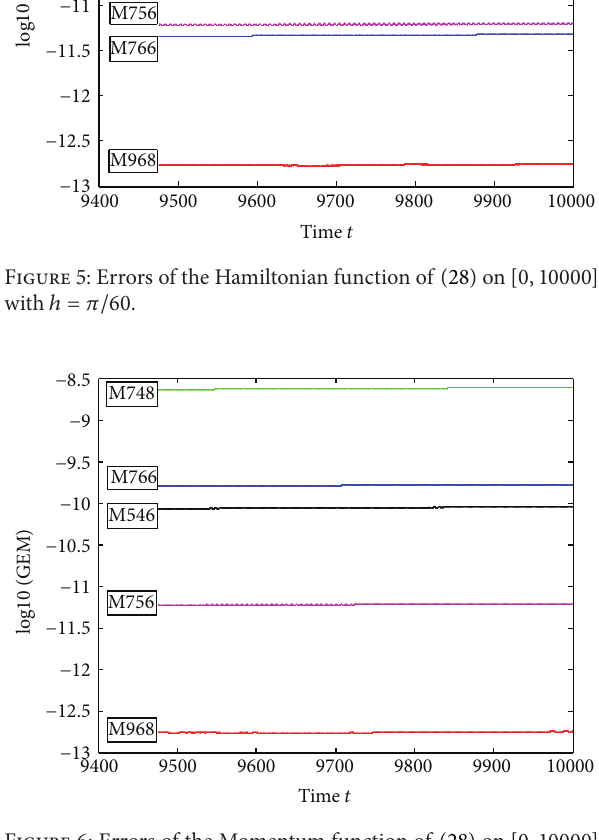
Figure 6: Errors of the Momentum function of (28) on [0, 10000] , with ℎ = 𝜋/60